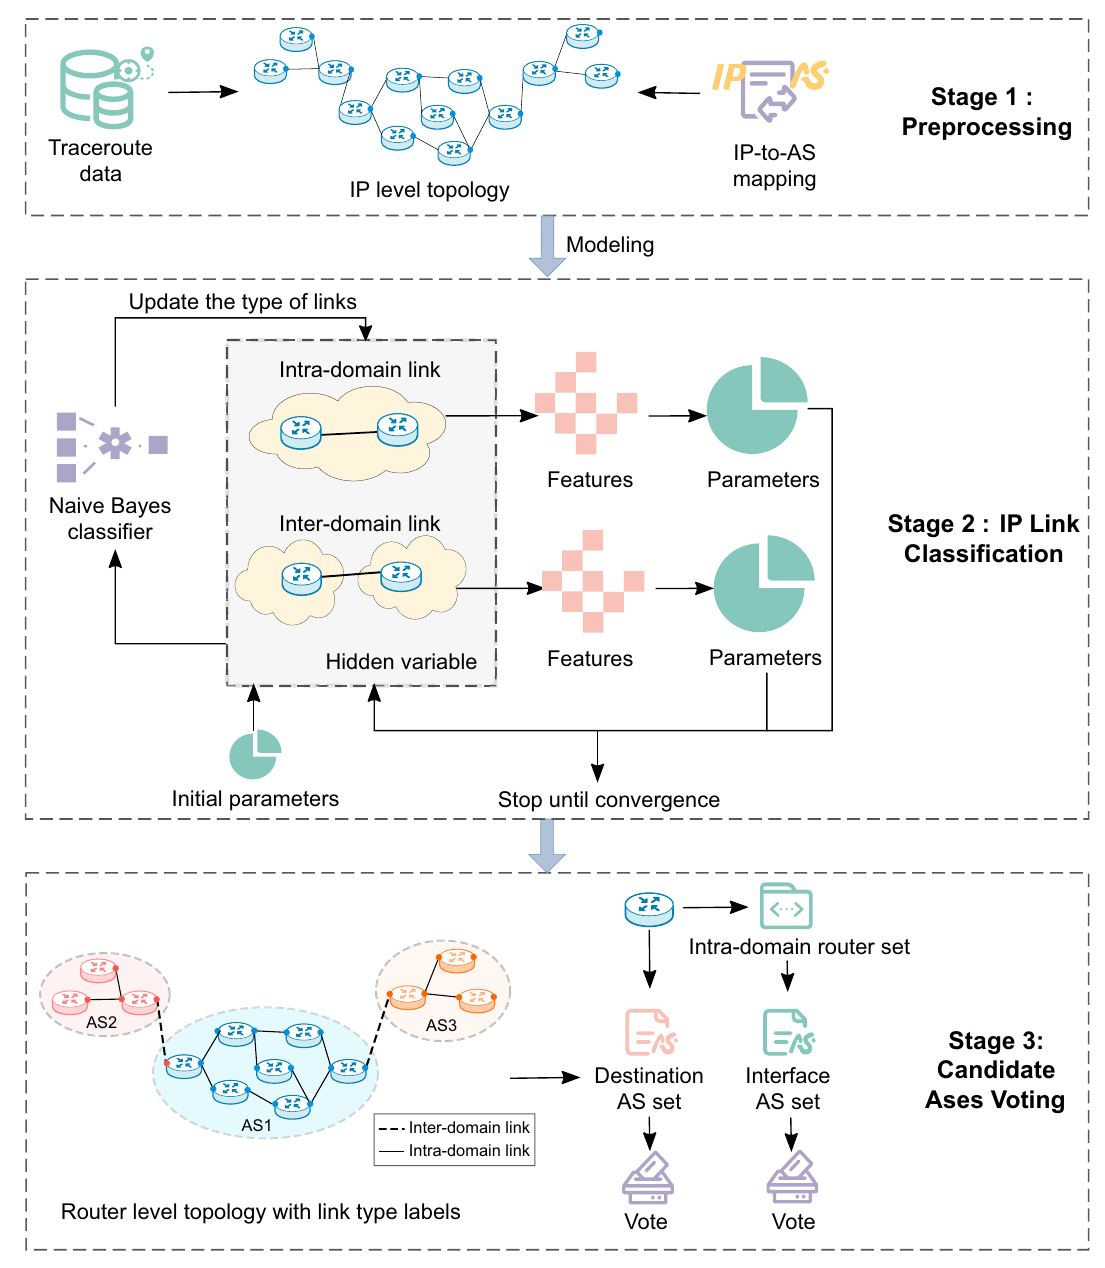
Figure 2. The process of the proposed LCROI